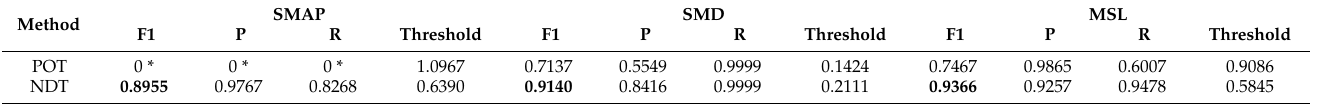
Table 6. The effects of the threshold calculation method. The best results are highlighted in